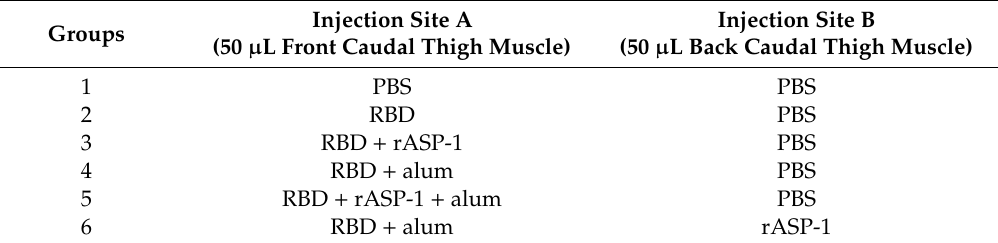
Table 1. Immunization of mice using di ff erent combinations and / or formulations of the vaccines and the site of injection: C57BL / 6 mice were immunized intramuscularly (i.m.) with MERS-RBD-Fd (RBD) formulated with or without alum and / or rASP-1 alone or together in di ff erent combinations and / or formulations. Mice were immunized twice, 3 weeks apart according to the various G1–G6 experimental groups either at the front (A: 50 µ L of inoculum) and / or the back (B: 50 µ L of inoculum) of the caudal thigh muscle in each hind